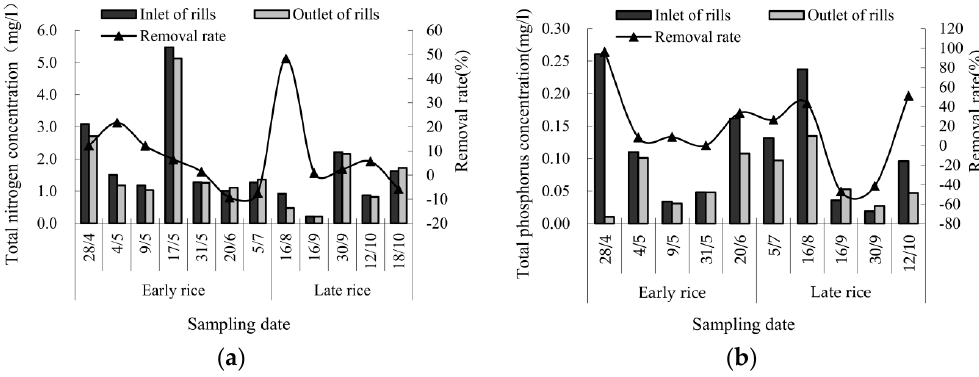
Figure 3. Effect of farm ditch on total nitrogen and total phosphorus removal: ( a ) Reduction of total nitrogen concentration; ( b ) Reduction of total phosphorus concentration.